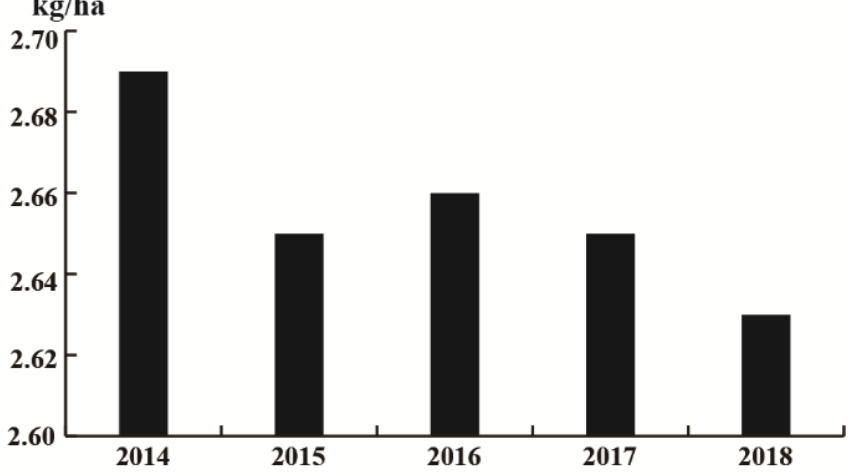
Figure 2. Pesticide application per hectare in recent years.